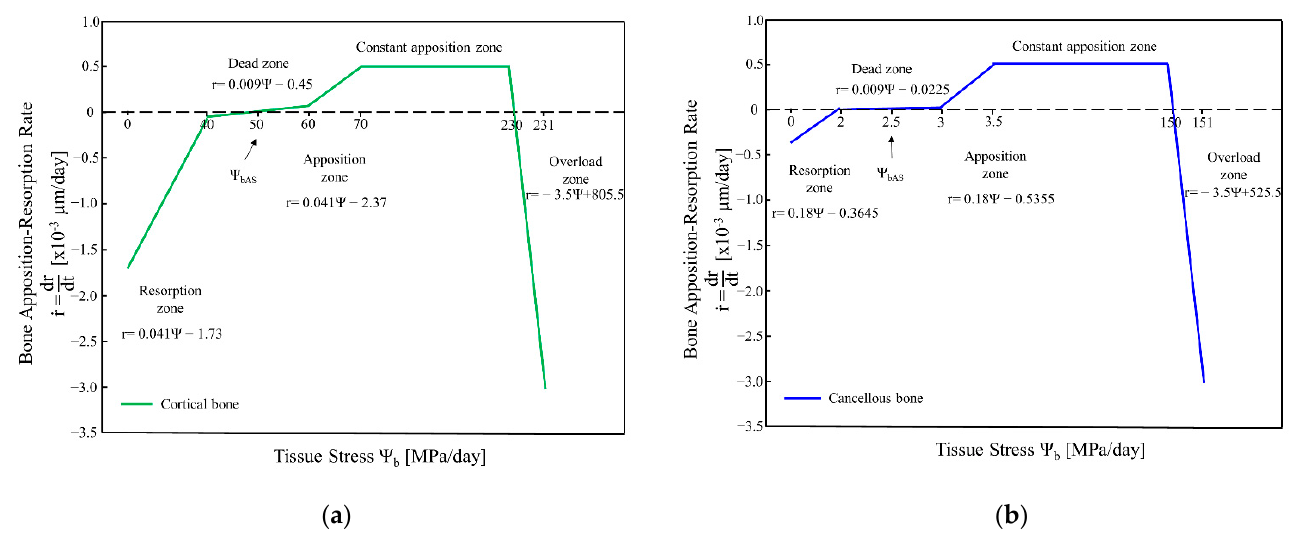
Figure 1. Remodelling curve for: ( a ) cortical bone; ( b ) cancellous bone. Taken from [50]. For internal bone remodelling, the change in density is described by a first-order linear differential equation (Equation (2)).